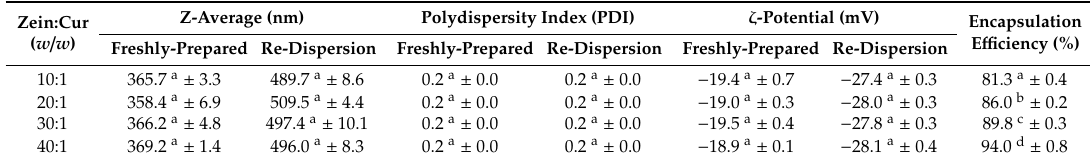
Table 2. Characteristic data of the Cur ‐ loaded zein ‐ caseinate ‐ pectin particles a .